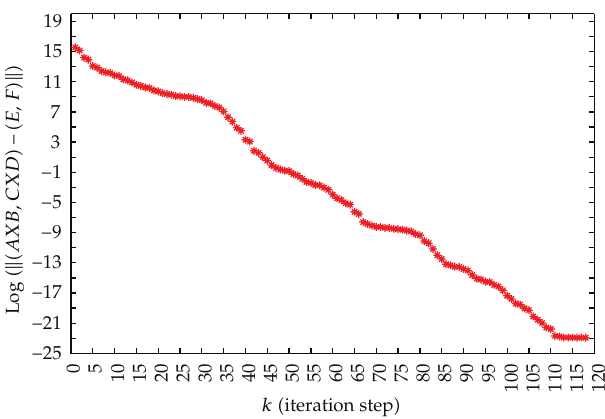
Figure 2: Convergence curve for the Frobenius norm of the residual for Example